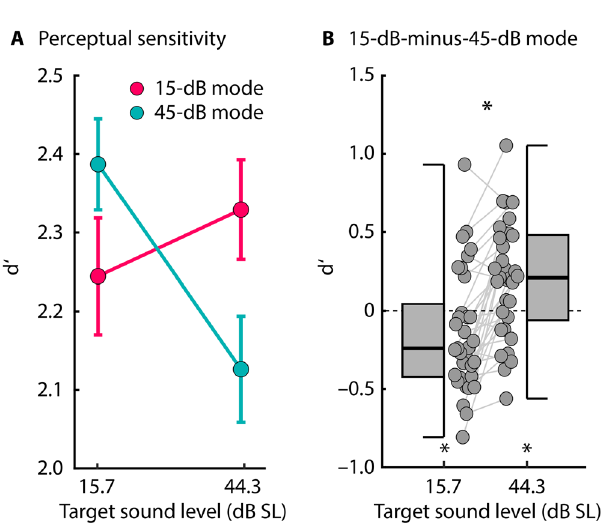
Figure 7. Perceptual sensitivity (d ′ ) for detecting amplitude-modulated target noises in two sound-level contexts. ( A ) d’ for detecting amplitude-modulated target bursts for different target-intensity categories (one centered on 15.7 dB SL and one on 44.3 dB SL) for the 15-dB SL and the 45-dB SL contexts. Error bars reflect the standard error of the mean (removal of between-subject variance 67 ). The interaction is significant (p < 0.05). ( B ) Difference in d’ between the 15-dB SL and 45-dB SL contexts, separately for low- and high-intensity targets. A positive value means a larger d’ for the 15-dB SL compared to the 45-dB SL context, and a negative value a larger d’ for the 45-dB SL compared to the 15-dB SL context. * p ≤ 0.05.